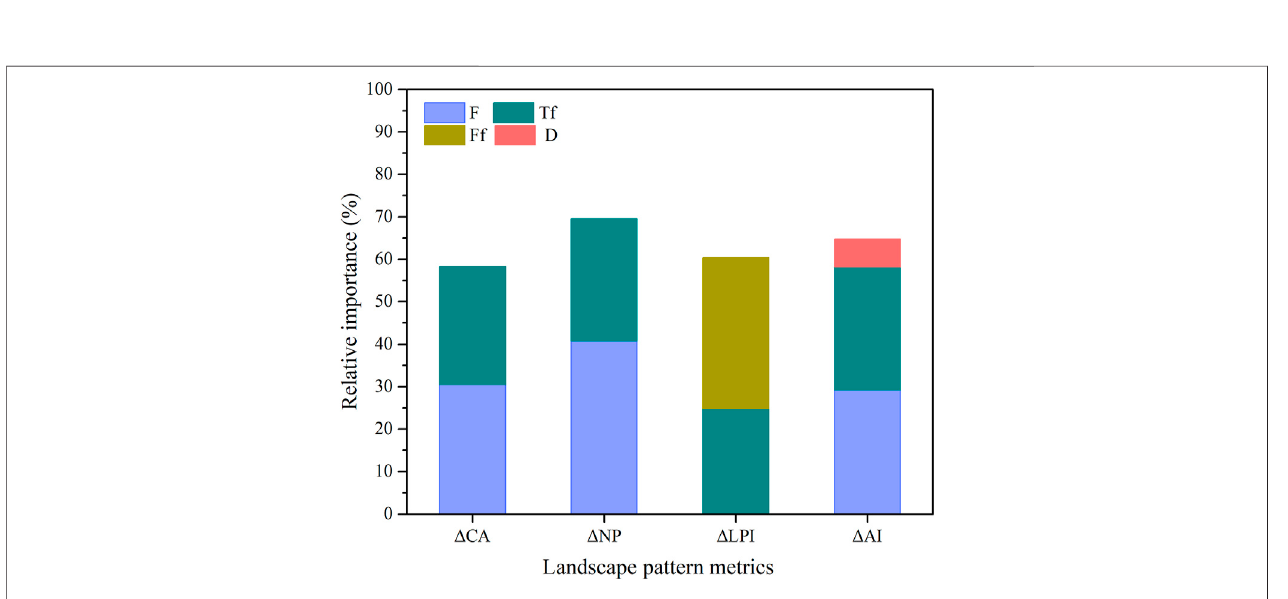
FIGURE 7 | The relative contribution of fl ow-sediment regime variables in the optimal GLMs to landscape pattern changes of S. alterni fl ora.